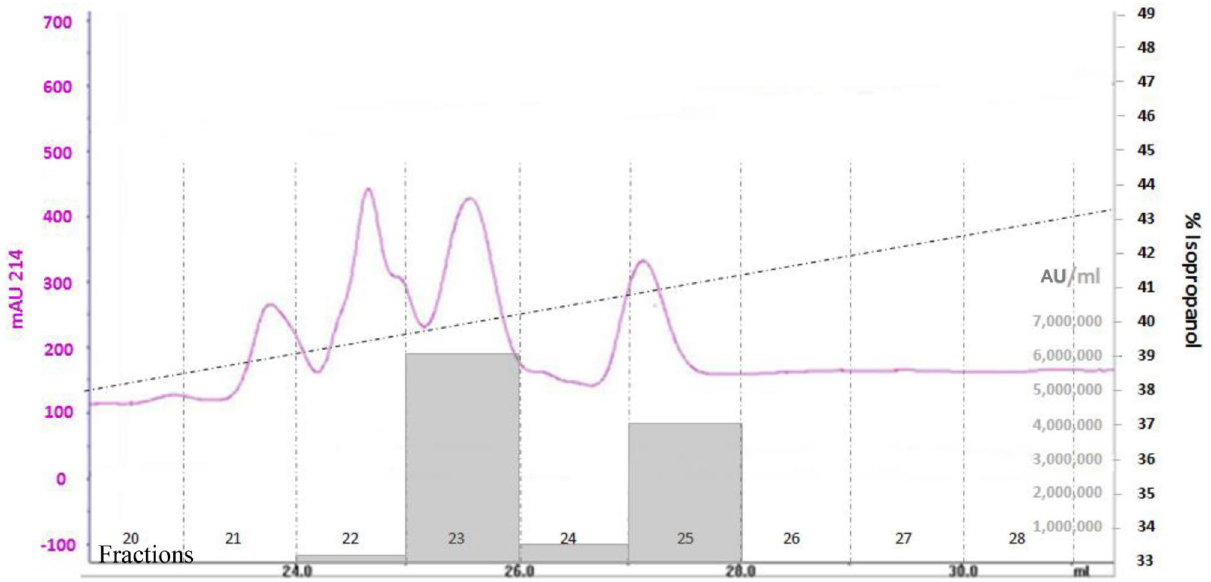
Figure 2. Second reversed-phase chromatography using the Sephasil peptide C 8 column. This shows two peaks with antimicrobial activity eluted at approximately 39.5% and 40.5% (v/v) isopropanol. The solid line shows the absorbance at 214 nm, while the broken line shows the elution gradient of isopropanol. The antimicrobial activity (AU/mL) is shown as gray